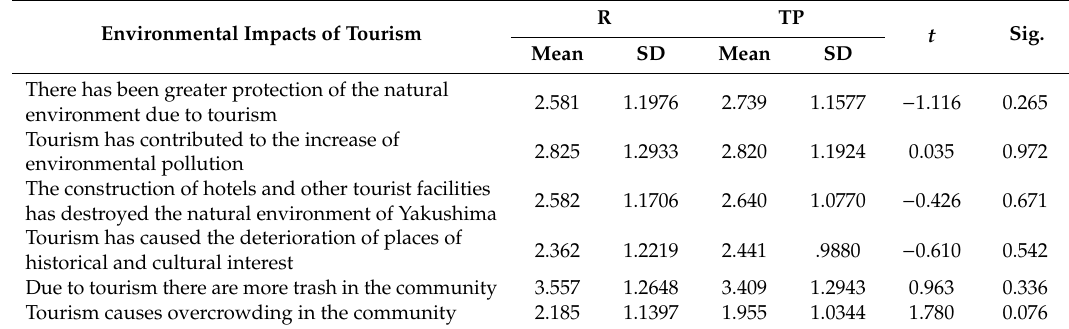
Table 2. Test of significance between residents and tourism practitioners ( t -Test).